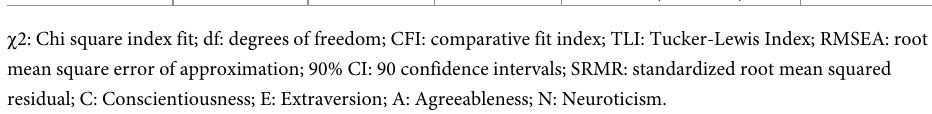
Table 4. Goodness-of-fit indices for personality traits ( N = 118).